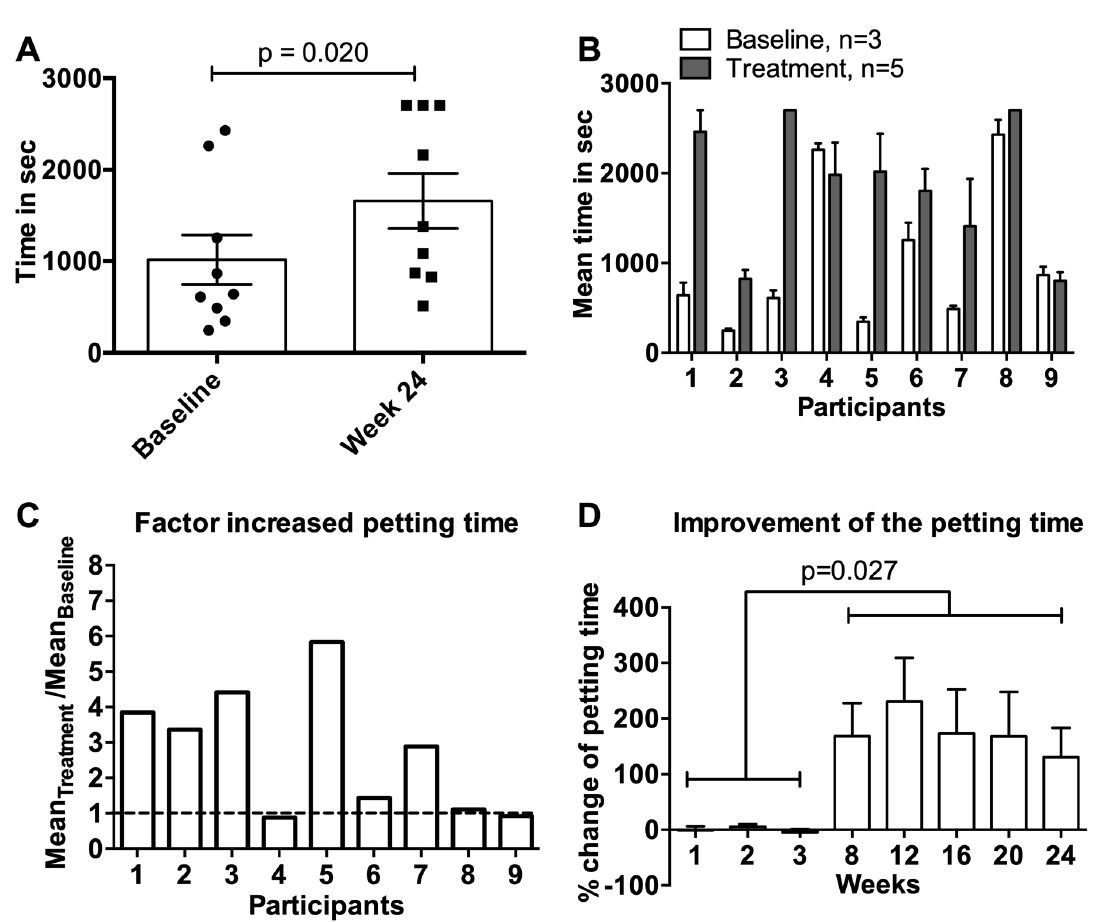
Figure 3. Time of petting as part of the provocation test. ( A ) Mean petting time with SEM in seconds of nine participants comparing baseline ( n = 3) versus week 24 at the end of the study. ( B ) Individual mean petting time with SEM in seconds at baseline ( n = 3, weeks 1–3) compared to treatment period ( n = 5, weeks 8, 12, 16, 20 and 24). ( C ) Factor of changed petting time for each participant shown as ratio of the mean timepoints during treatment ( n = 5, weeks 8, 12, 16, 20 and 24) to mean baseline time ( n = 3, weeks 1–3). ( D ) Change in % of the mean petting time with SEM of nine participants during the treatment period in weeks 8, 12, 16, 20 and 24 compared to mean baseline in weeks 1–3. Statistical significances were obtained by an exact Wilcoxon matched-paired signed rank